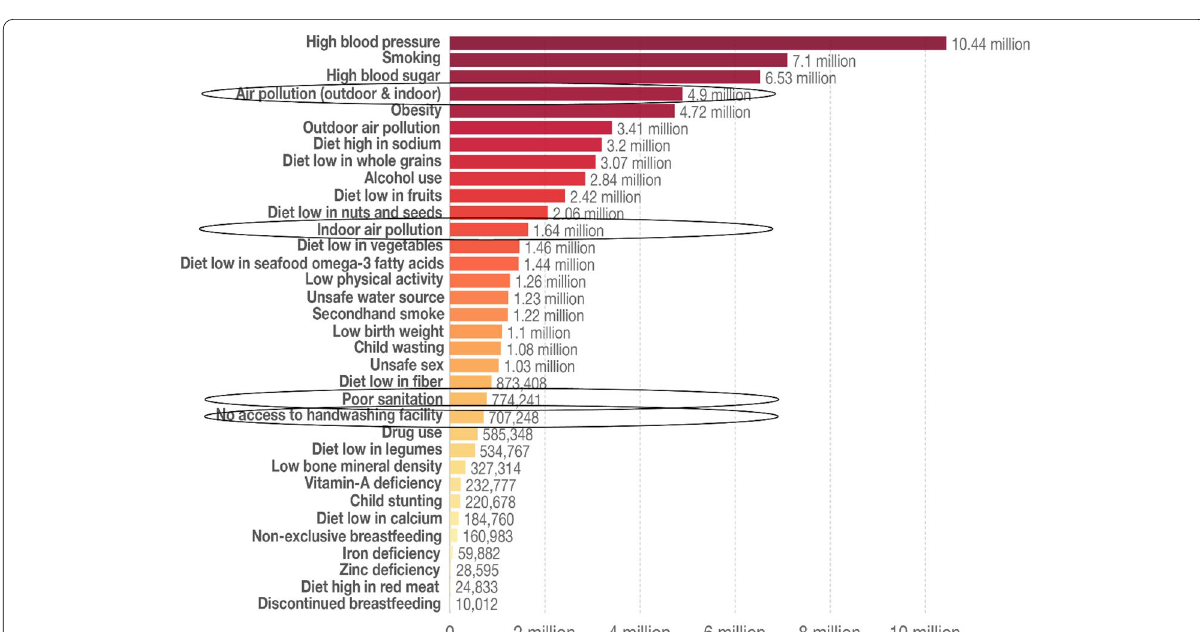
Fig. 5 Number of deaths by risk factors, 2017. Adapted from Global Burden of Disease